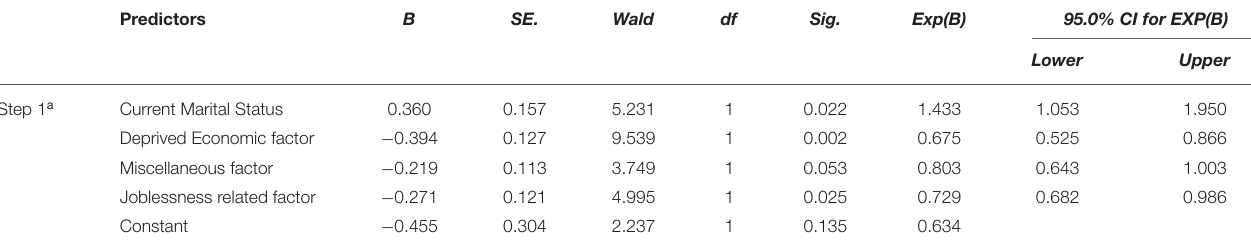
TABLE 12 | Variables in the equation (multivariate binary logistic regression).